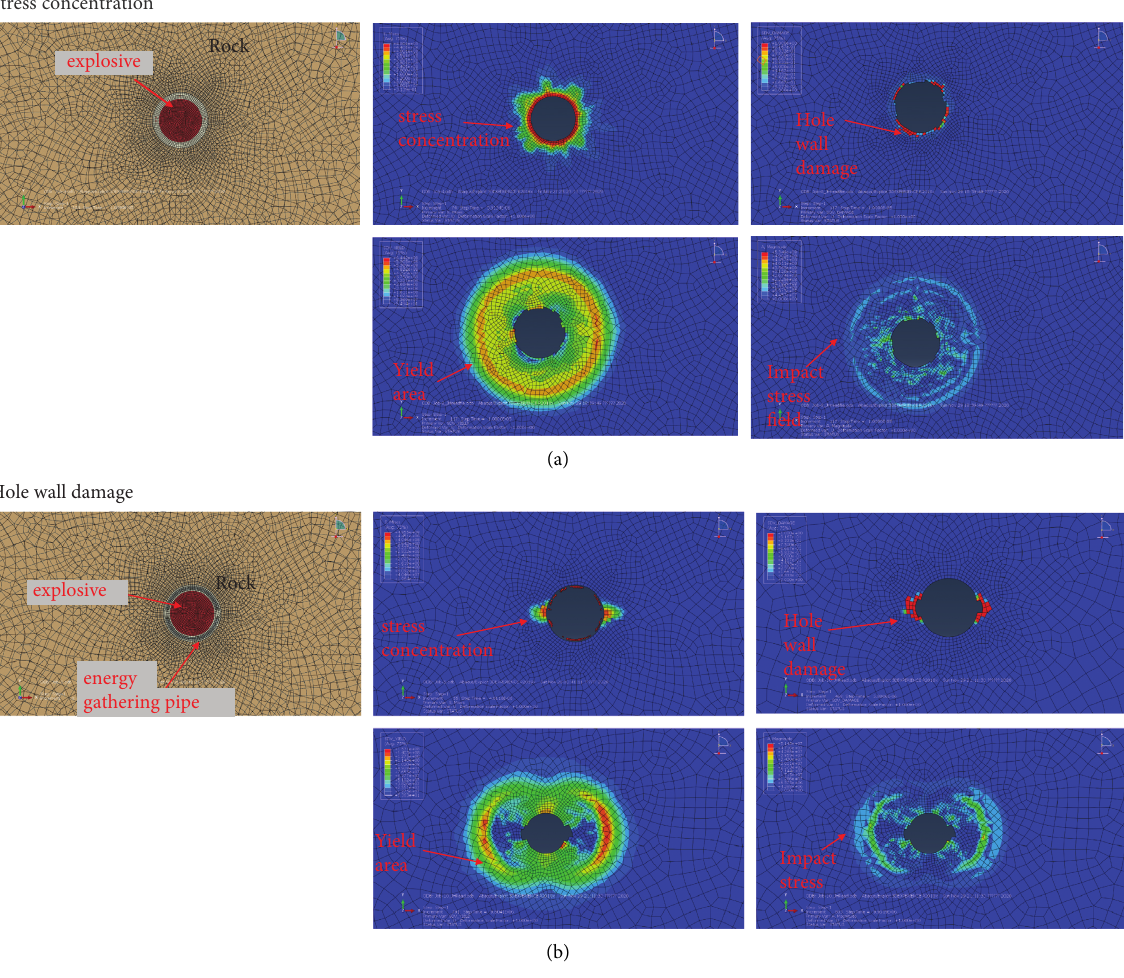
Figure 6: Simulation of blasting damage to rock: (a) without adding energy gathering pipe and (b) by adding energy gathering pipe.